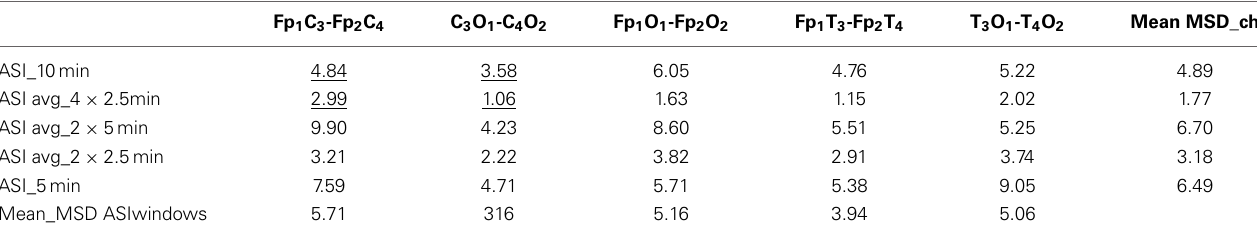
Table 1 | Mean squared difference (MSD) for different channel pairs and different ASI analyzing window lengths shown as an average for all 31